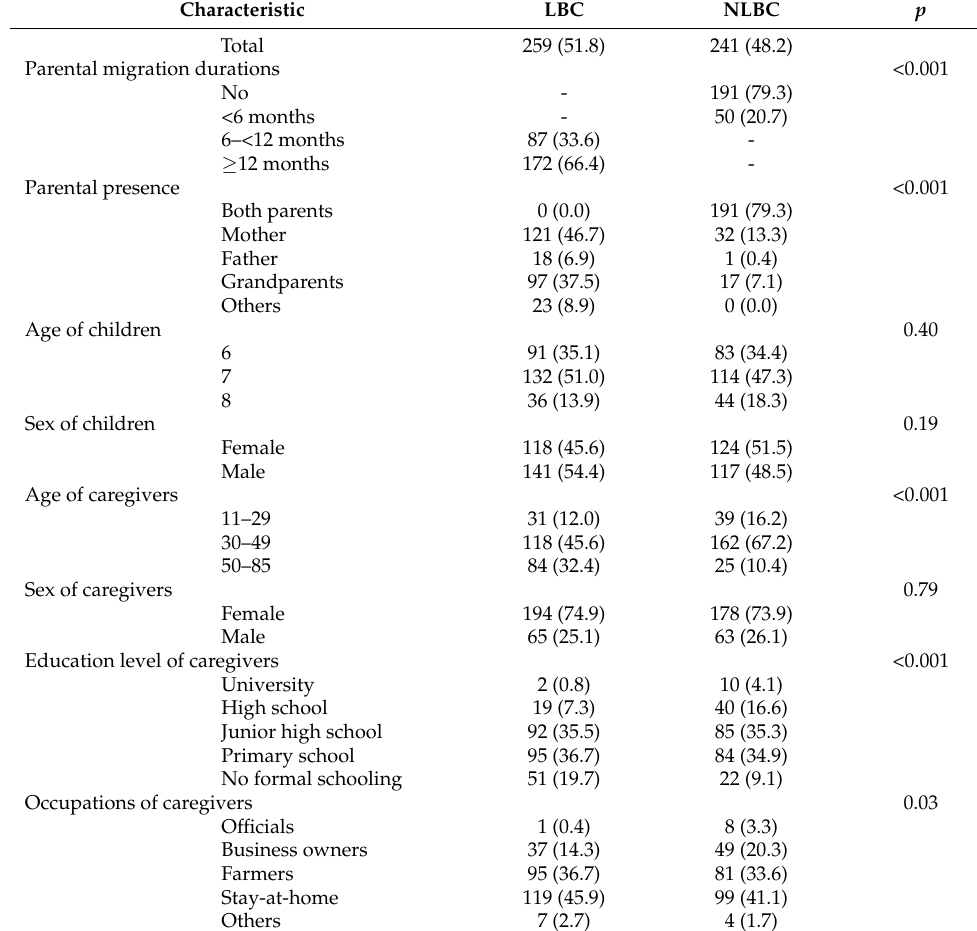
Table 1. Sociodemographic characteristics of participants, n